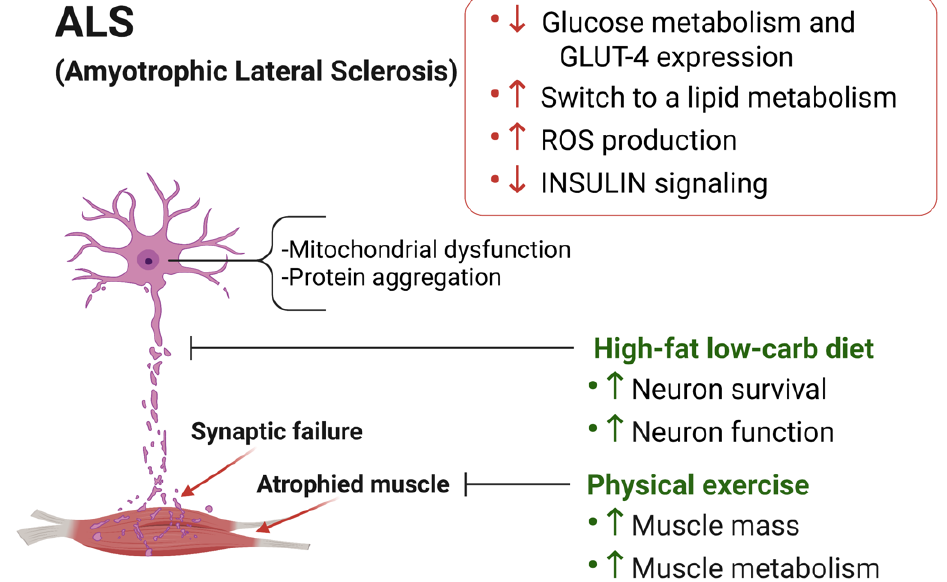
Figure 2. Skeletal muscle metabolic reprogramming and proposed approaches to counteract disease progression. Among the metabolic pathways affected in ALS muscle are glucose and lipid metabolism, reactive oxygen species (ROS) production and insulin signaling (red box). Reduced glucose transport and uptake, increased lipid metabolism, and ROS-mediated oxidative stress result in metabolic dysfunction. A high-fat-low-carb diet and physical exercise have been shown to have protective effects on neurons and skeletal muscles in